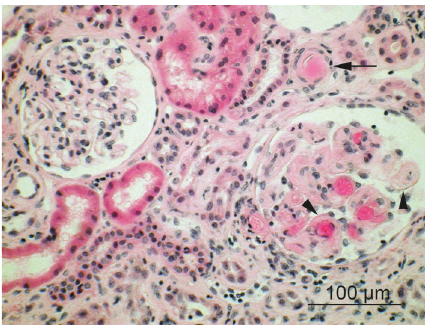
Figure 2: Histological examination showing thrombotic microan- giopathy in a kidney biopsy from renal allograft at day 120 (hema- toxylin and eosin). Microthrombi and lucent deposits (arrowheads) are observed in the glomerulus at the right side, with obstruction of a nearby arteriole by eosinophilic material (arrow). Notice the unaffected glomerulus on the left side of the microphotograph. Thereisnoevidenceofacuteantibody-mediatedrejectionaccording to the 2015 Banff classification (g0, ptc0, and no C4d deposit by immunofluorescence (not